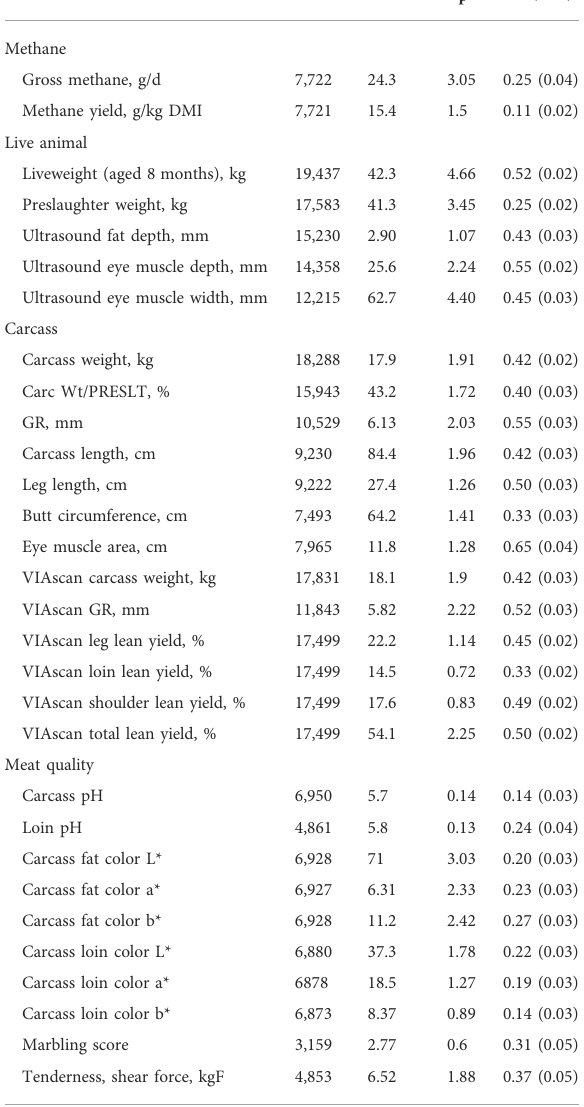
TABLE 2 Number of records/animals, mean, phenotypic standard deviation, and heritability estimate for methane, live animal, ultrasound, carcass, and meat quality